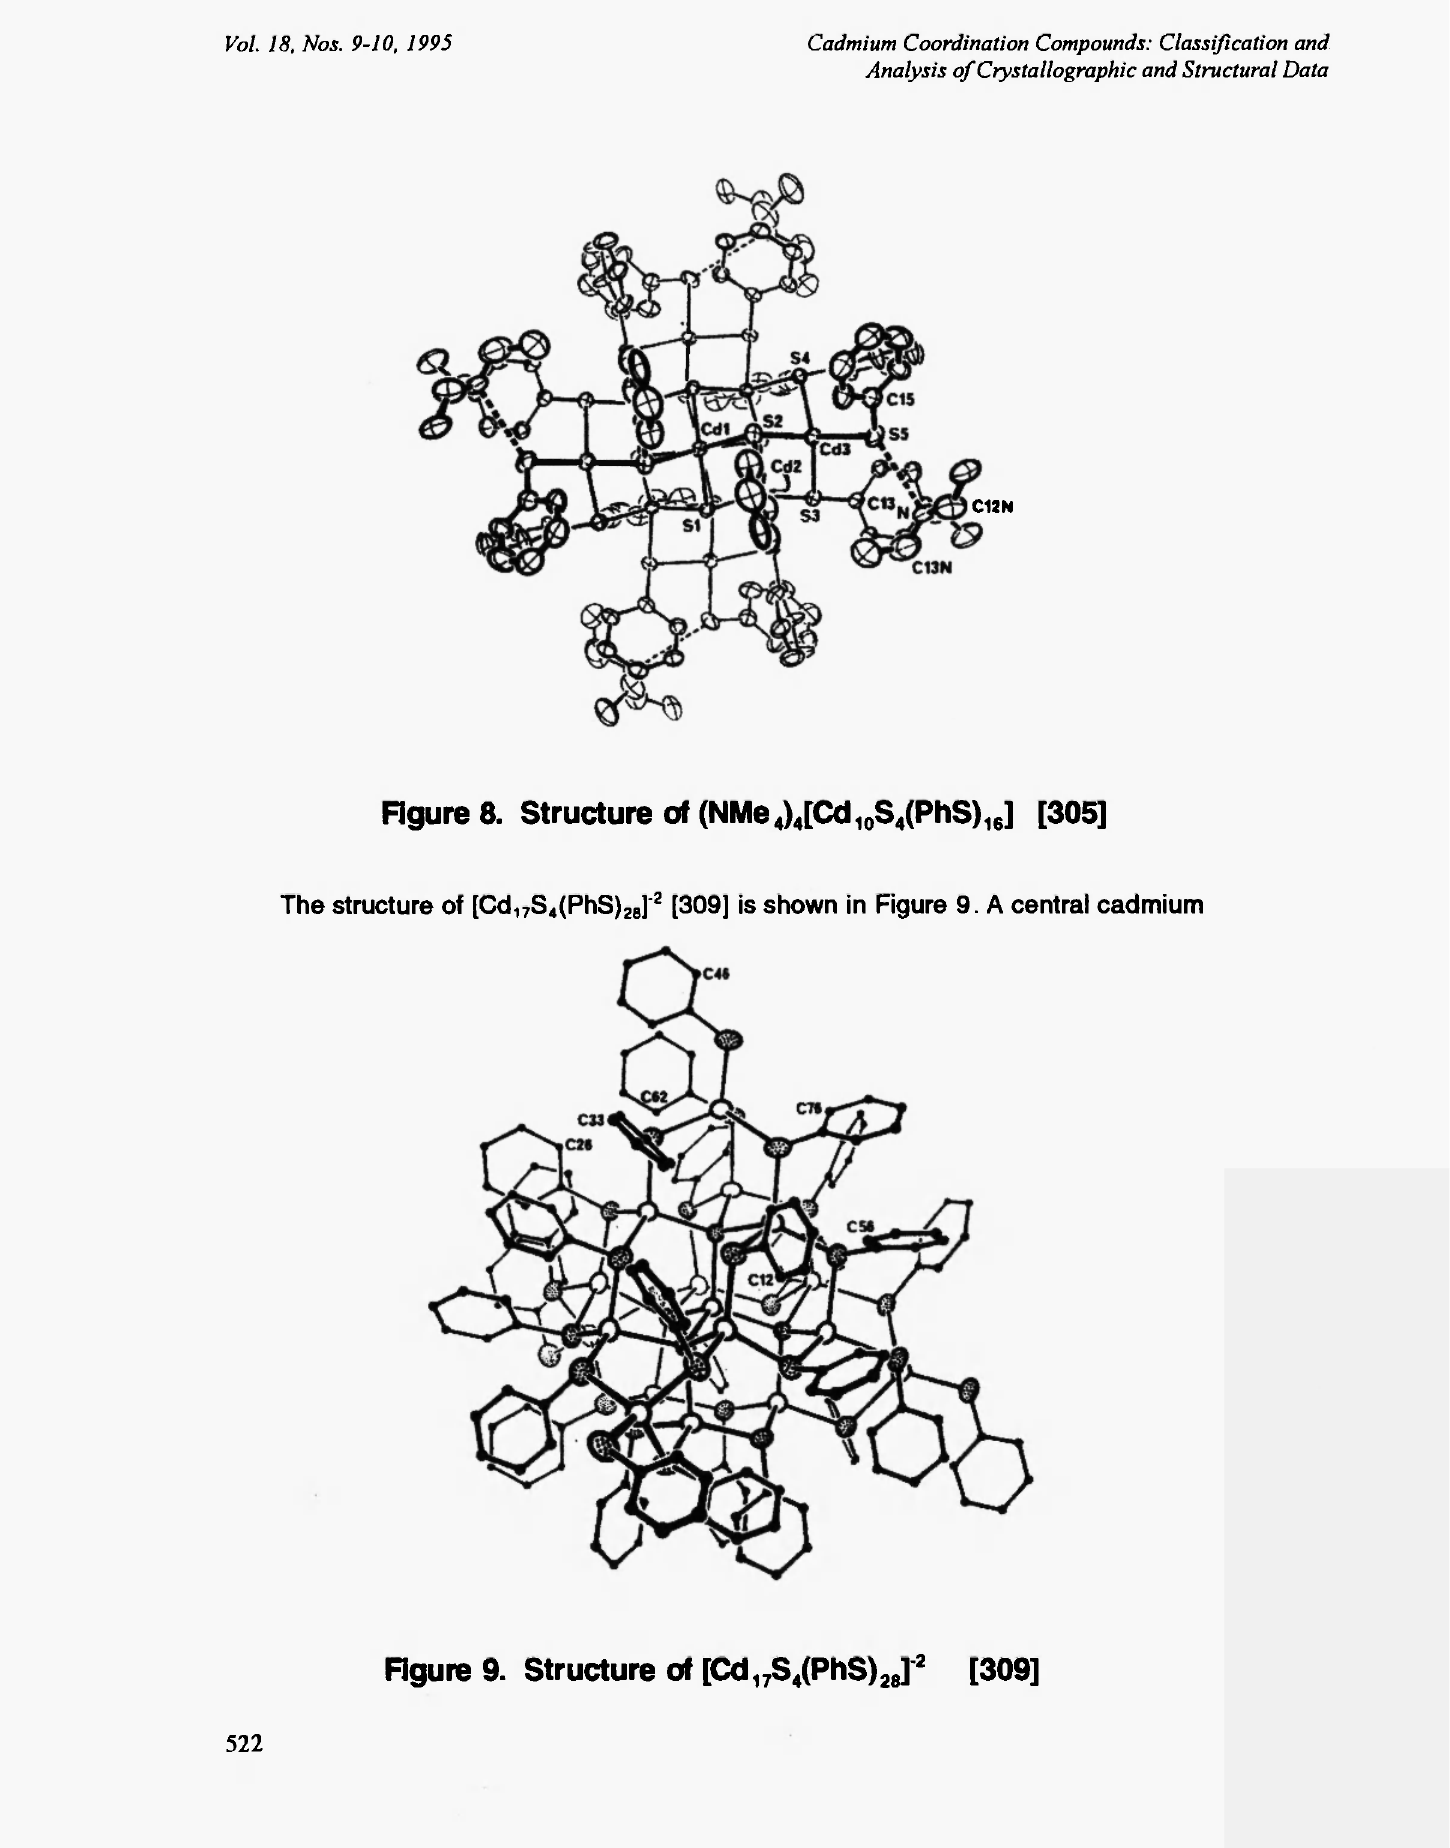
Figure 9. Structure of [Cd